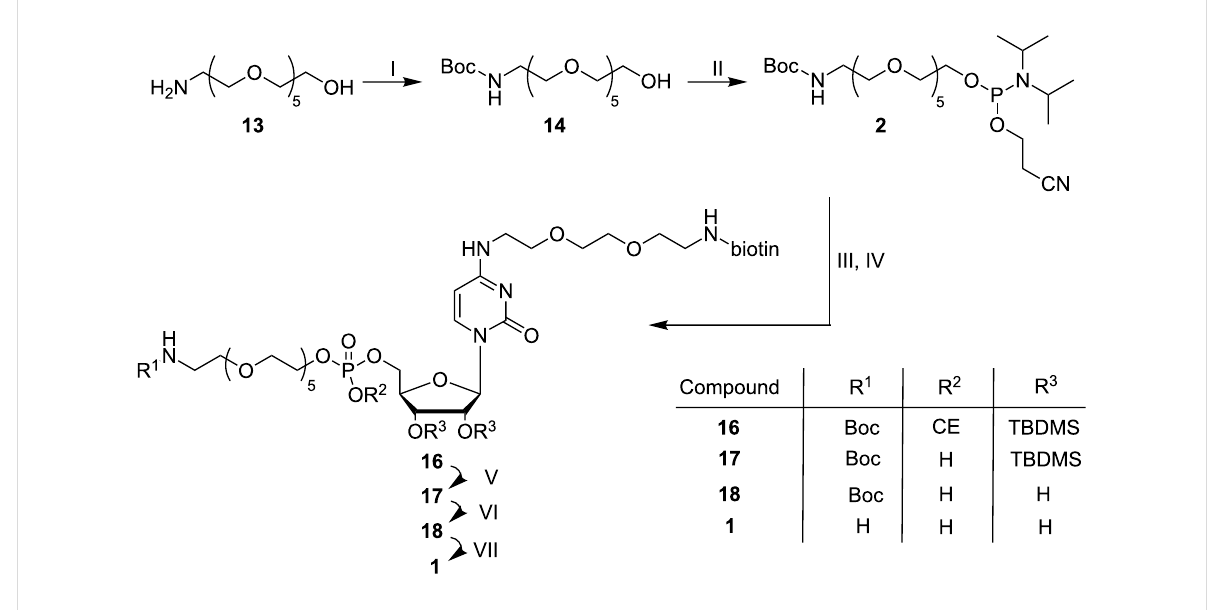
Figure 5: Formation of the phosphoramidite 2 from amino alcohol 13 , and subsequent coupling to the 5'- O -deprotected nucleoside 12 . I: 1.2 equiv di- tert -butyl dicarbonate, EtOAc, 60 °C, 1.5 h, 98%; II: 5.3 equiv DIPEA, 1.3 equiv (2-cyanoethyl- N , N -diisopropyl)chlorophosphoramidite, DCM, rt,